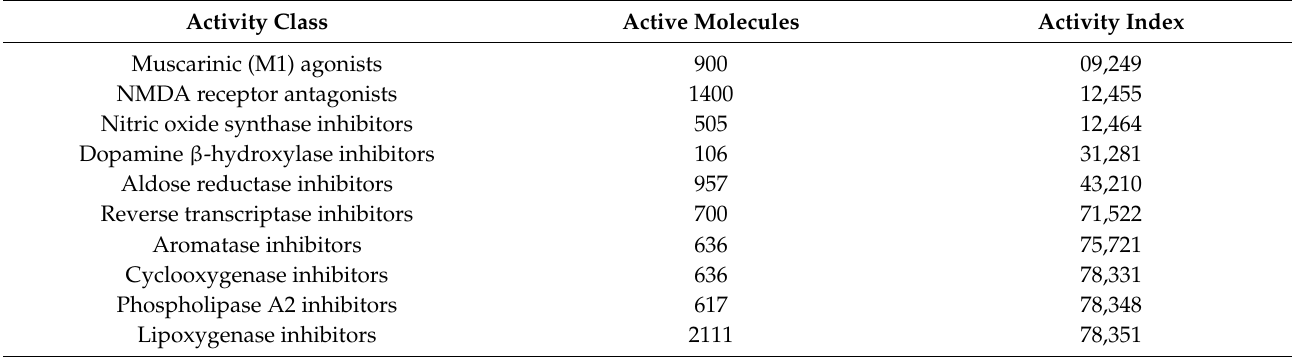
Table 3. The MDDR-DS3 structure activity